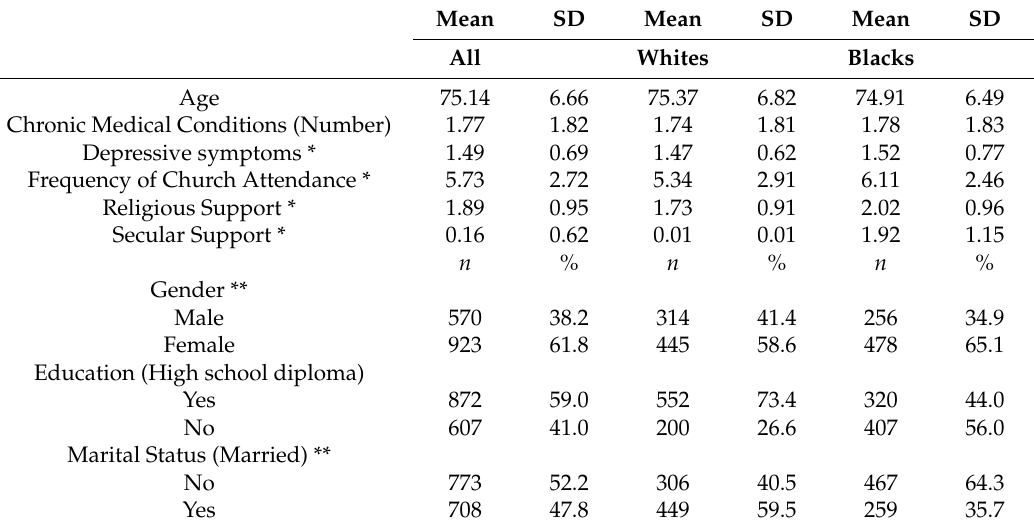
Table 1. Descriptive Statistics for the analytic sample, stratified by race and